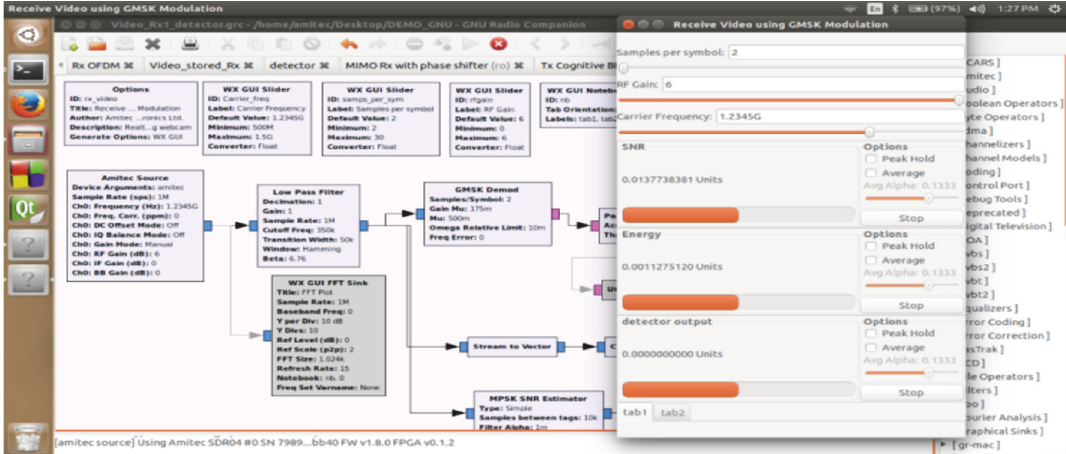
Figure 8: Energy based detector output is zero as the transmission